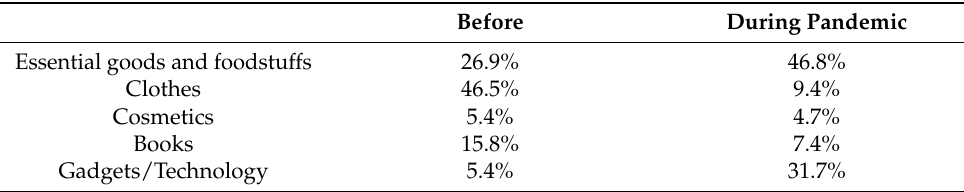
Table 2. Online purchases before and during the